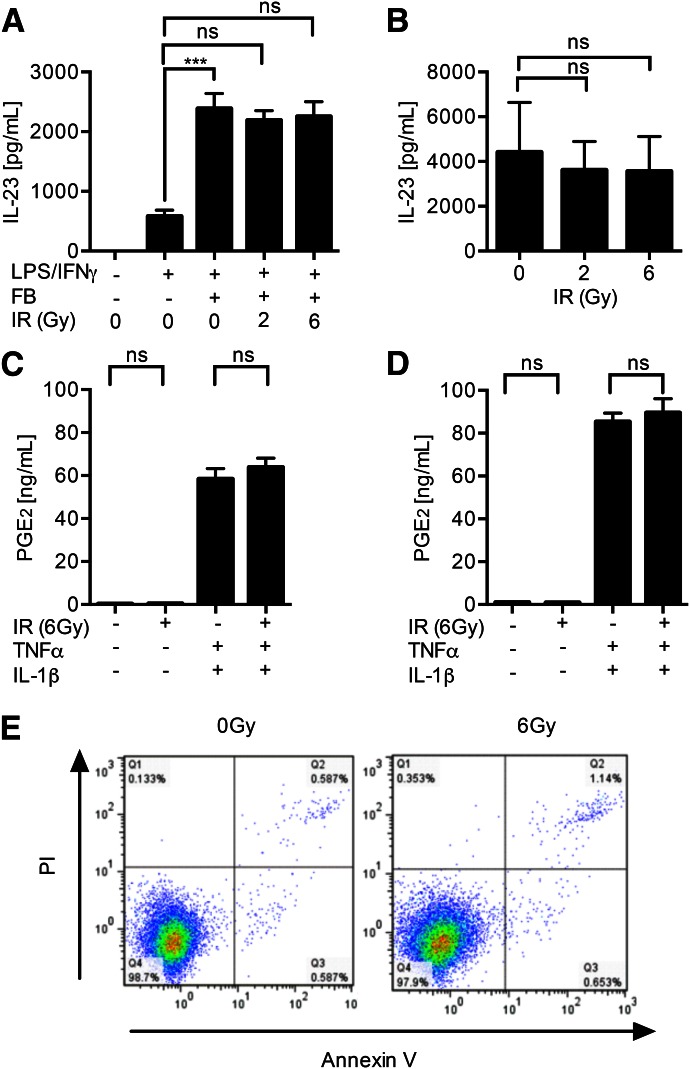
FBs are functionally resistant to IR.Irradiation of FBs did not impair their ability to up-regulate IL-23 secretion from nonirradiated DC. (A) A representative donor. (B) Summary of 3 donors. (C) PGE2 secretion (determined by ELISA) by FBs stimulated with rTNF-α and rIL-1β (1 ng/ml) is unaffected by IR; BJ6 cell line. (D) Representative results for 1 of 2 primary FB donors. (E) IR (6 Gy) does not affect FB viability up to 24 h after irradiation, as assessed by annexin V/PI staining; representative data from 3 experiments. ***0.001 > P ≥ 0.0001. Results are presented as means ± sd.